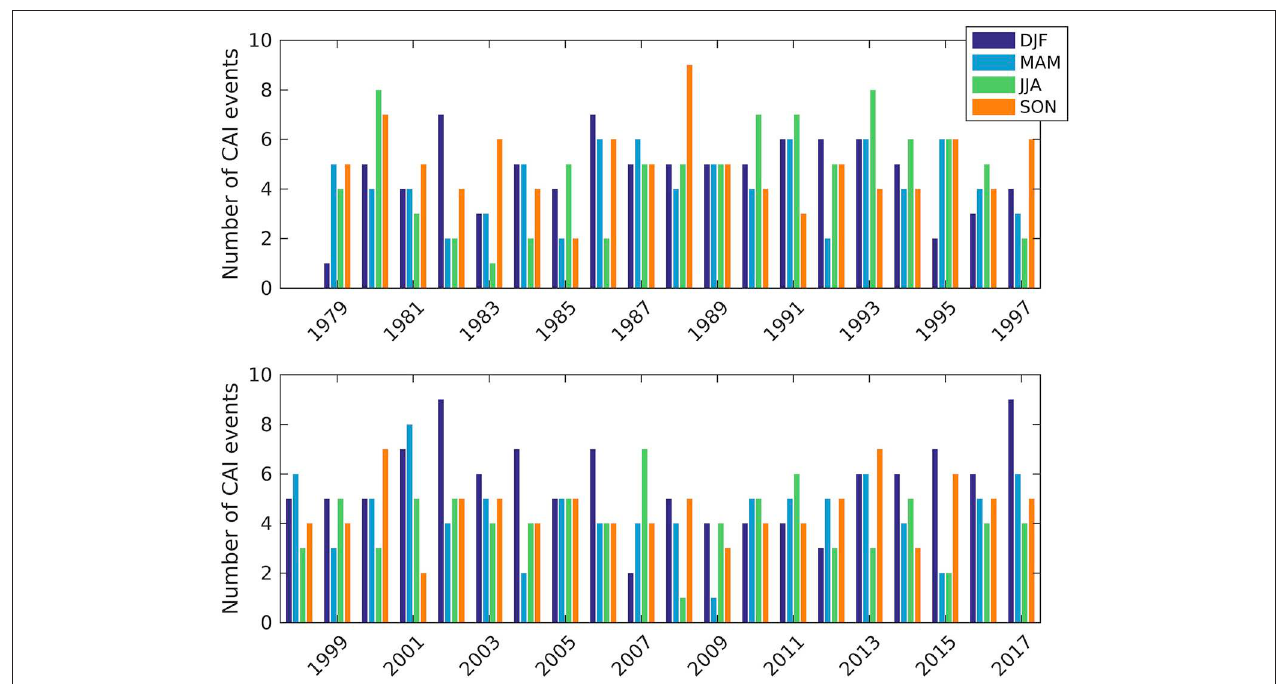
FIGURE 10 | Seasonal time series of CAI events detected from ERA-Interim data 1979–2017 for the eastern side of the Andes cordillera.